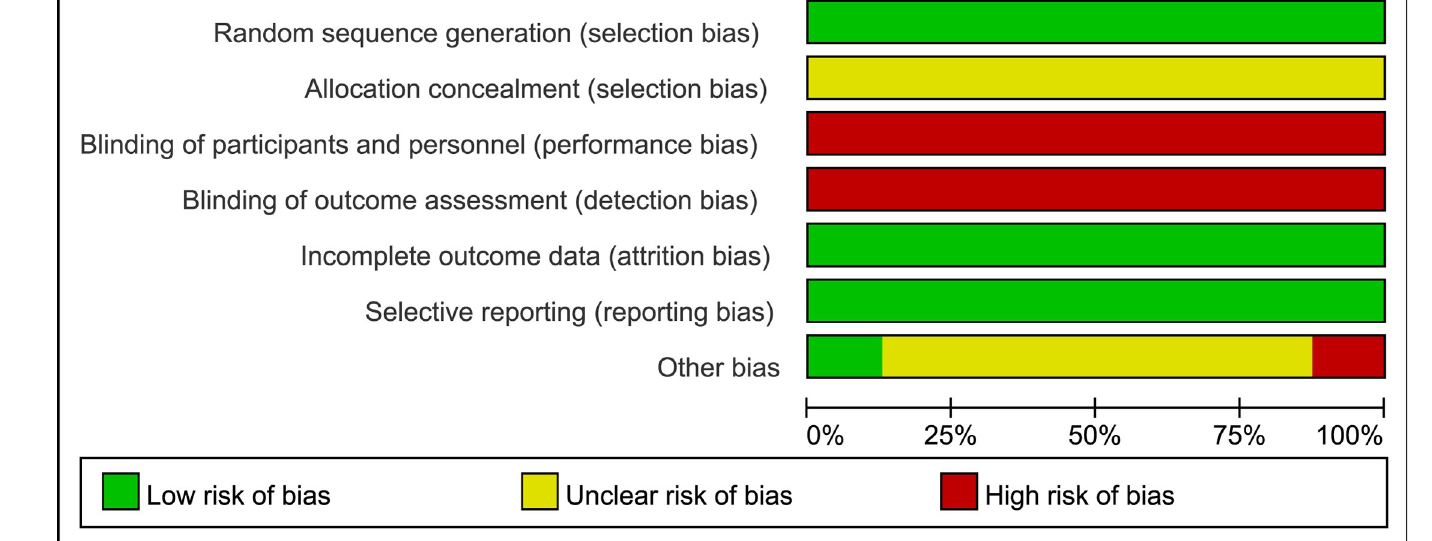
Fig 2. Graph of bias risk